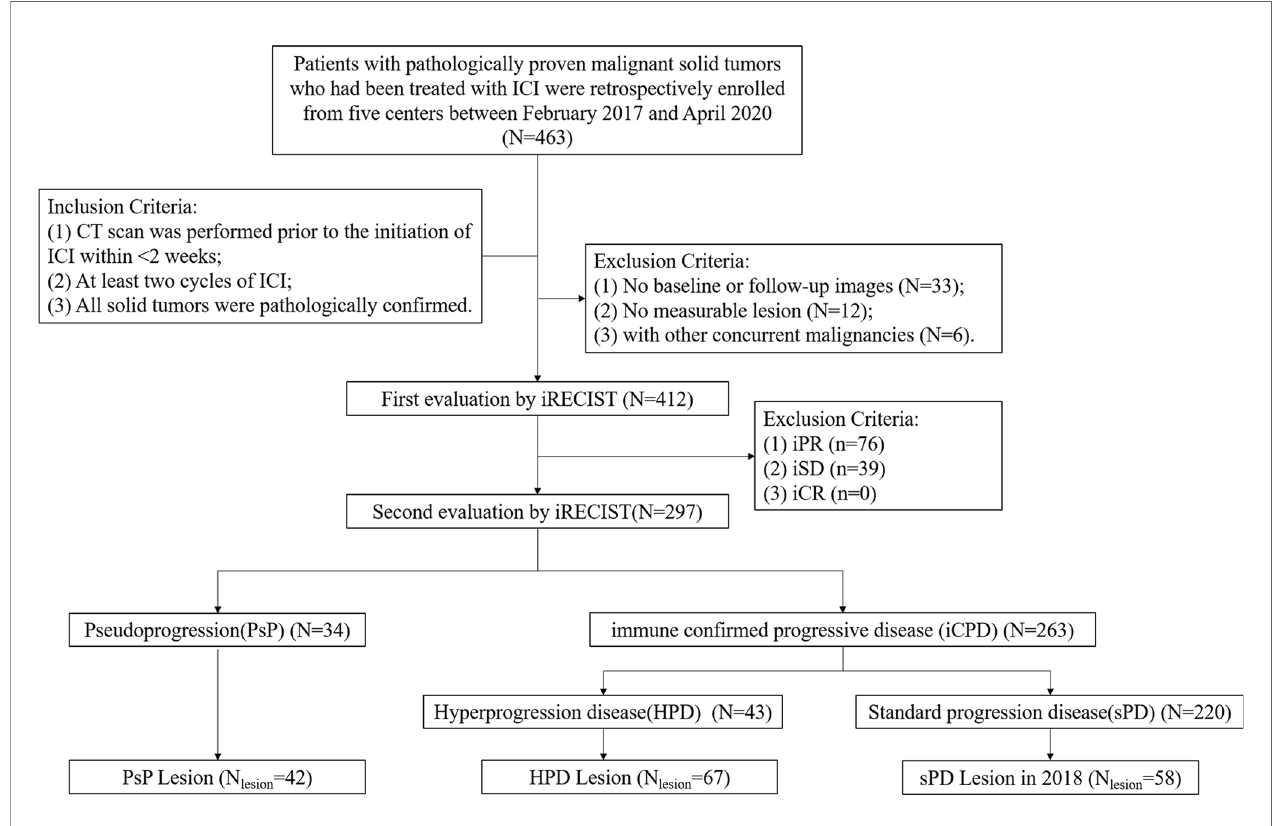
FIGURE 2 | Flowchart of the patient selection